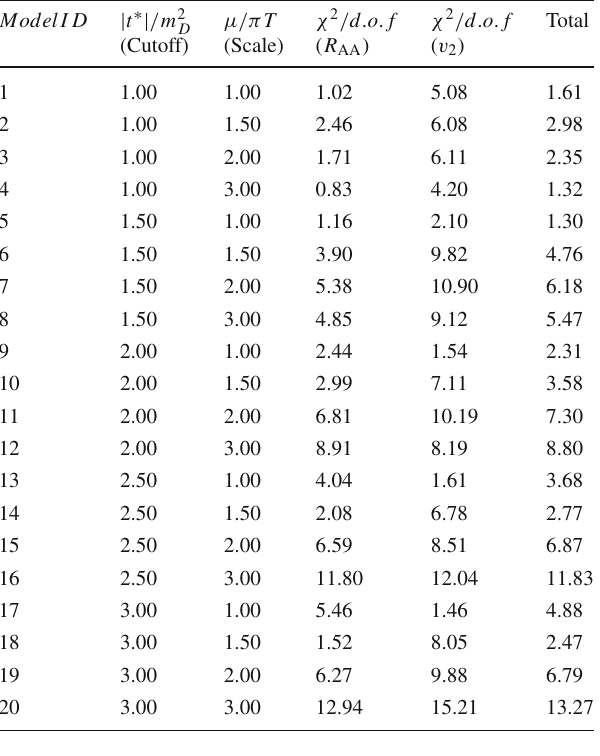
Table 1 Summary of the adjustable parameters in this work, together with the relevant χ 2 / d . o . f obtained for R AA and v 2 ModelI D